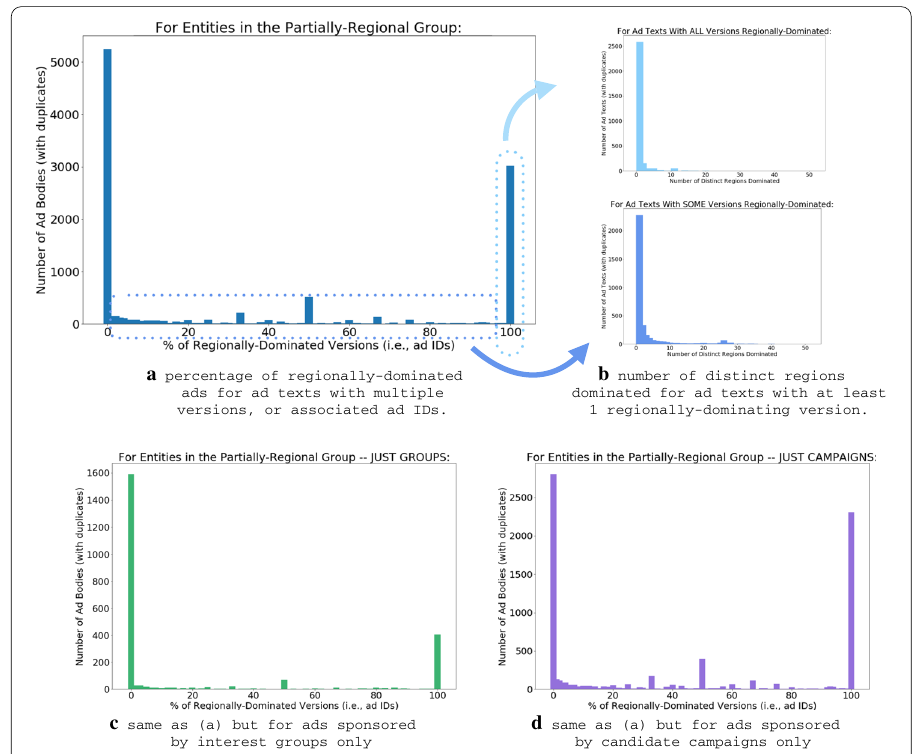
Fig. 13 a Number of ad duplicates (with the exact same creative body) versus the percentage of duplicates that are regionally-dominated (that is, they receive at least 99% of their impressions from one region). b Number of regions dominated across all regionally-dominated ads with the same text, for ad texts with only regionally-dominated versions (top) and some regionally-dominated versions (bottom). c Same as in a , but only for ads sponsored by interest groups. d Same as in a , but only for ads sponsored by candidate